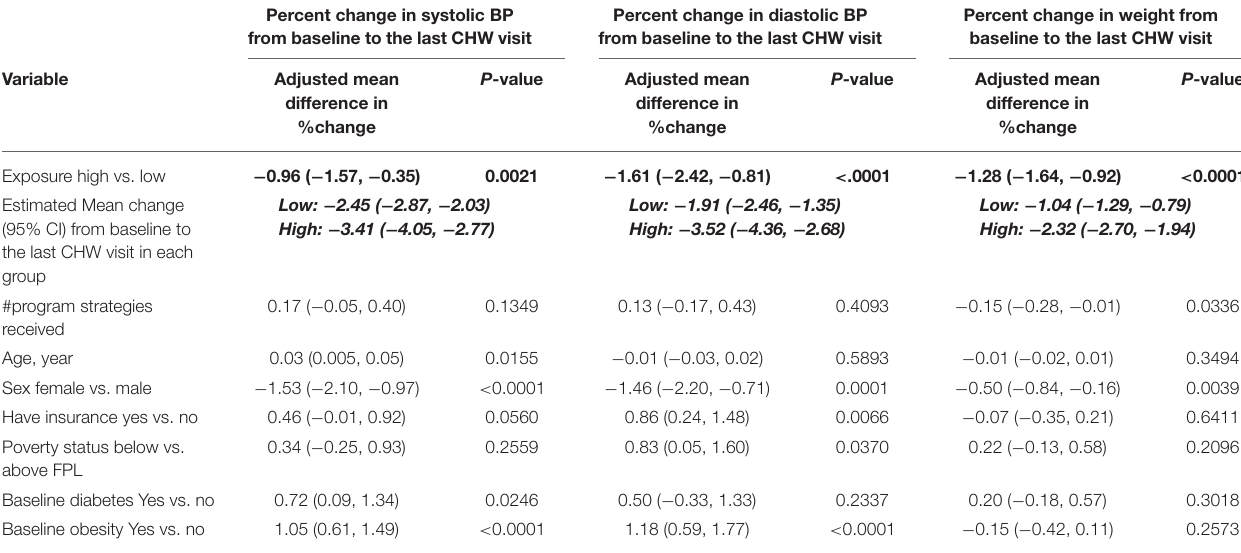
TABLE 2 | TSSC program effect on change in systolic and diastolic BP from baseline to last visit based on linear regression analysis ( N = 5,019). Percent change in systolic BP Percent change in diastolic BP Percent change in weight from from baseline to the last CHW visit from baseline to the last CHW visit baseline to the last CHW visit